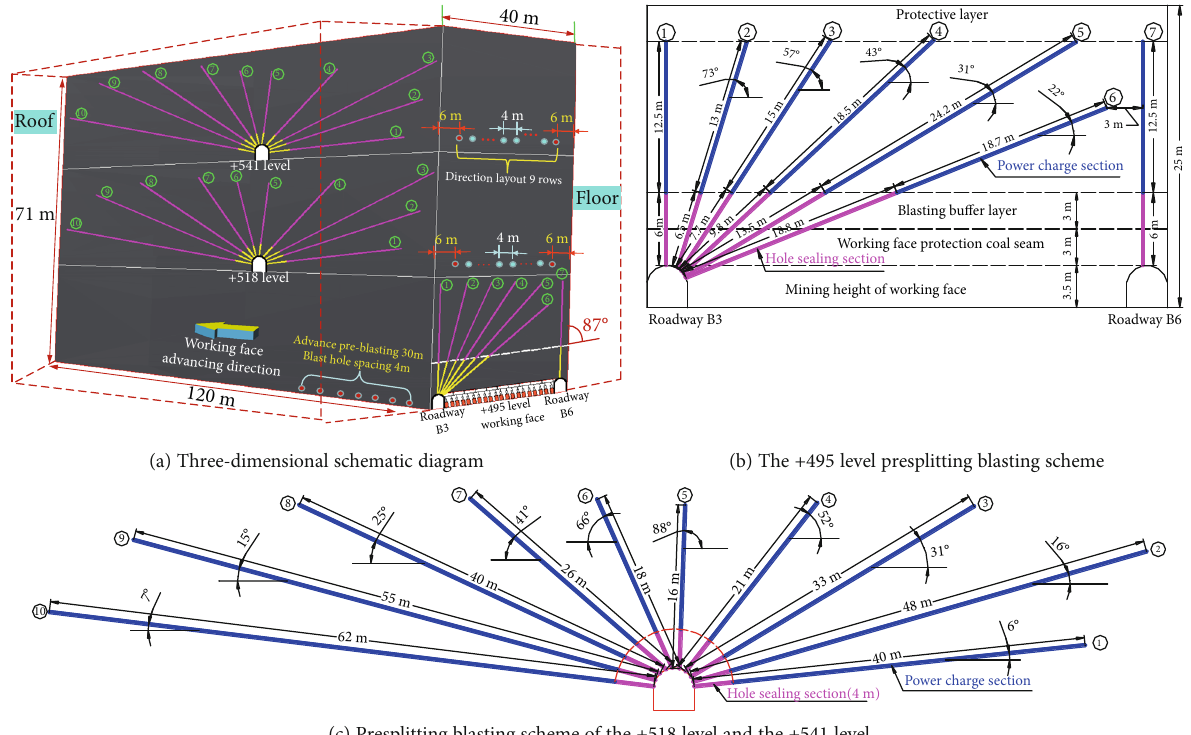
Figure 7: Sublevel advanced presplitting blasting scheme for the top coal in the residual high sectional coal pillar.